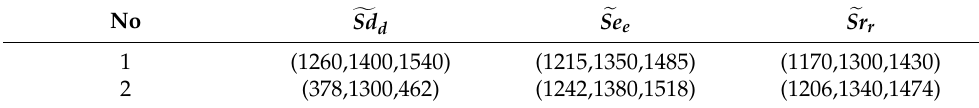
Table 10. Set up cost for constructing dismantling, repairing, and recycling centers (us dollar).